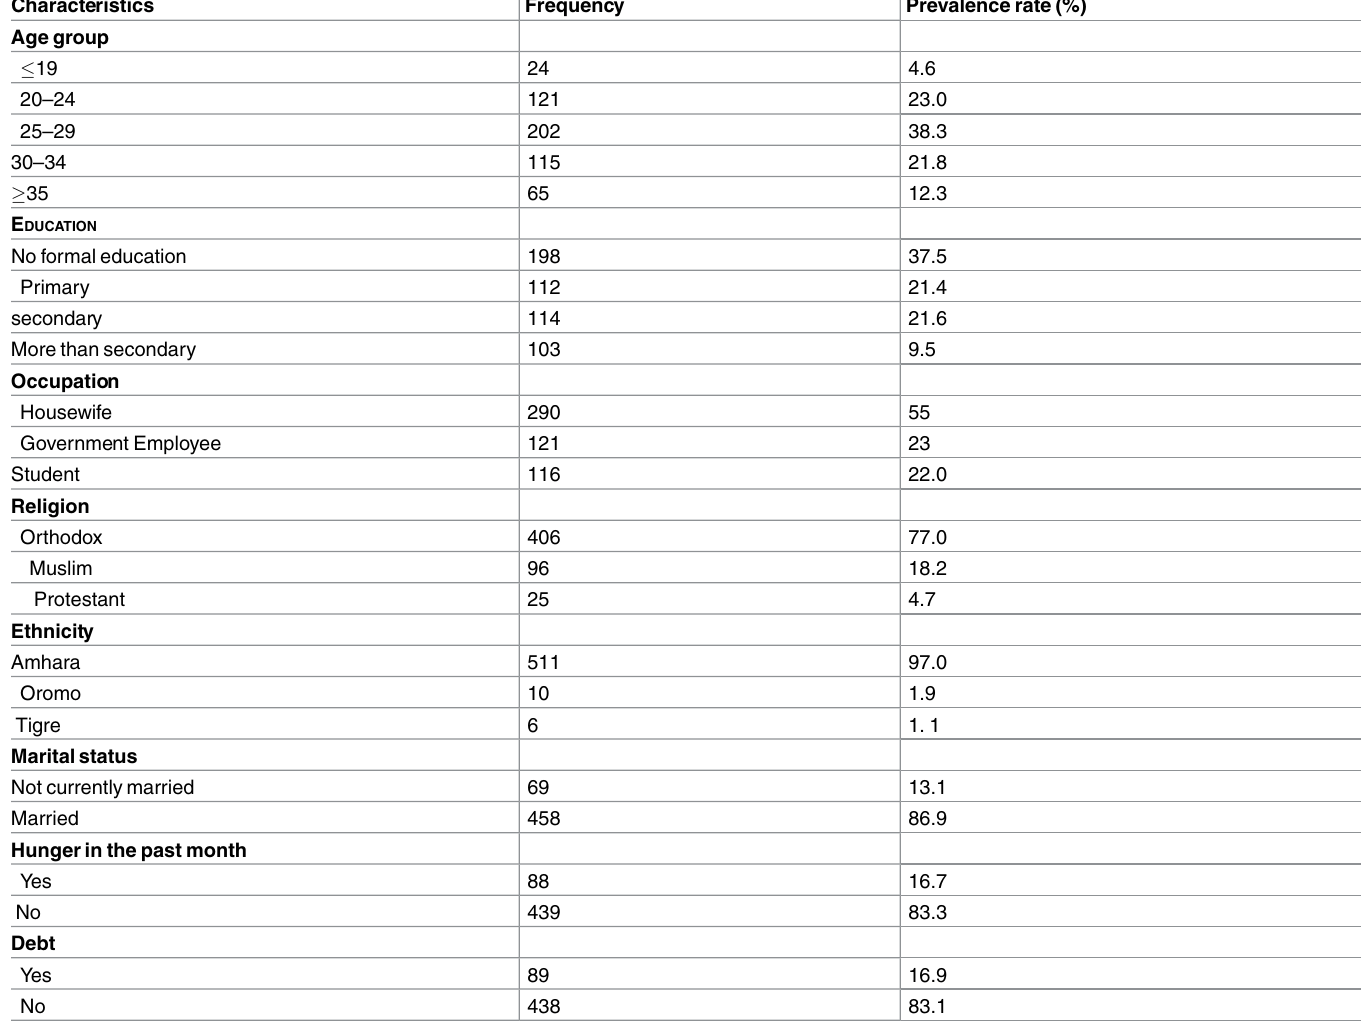
Table 1. Frequency distribution of Socio-demographic and socio-economicfactorsamongpregnant women at Debretabortown, NorthWest Ethi- opia,2013(n= 527).